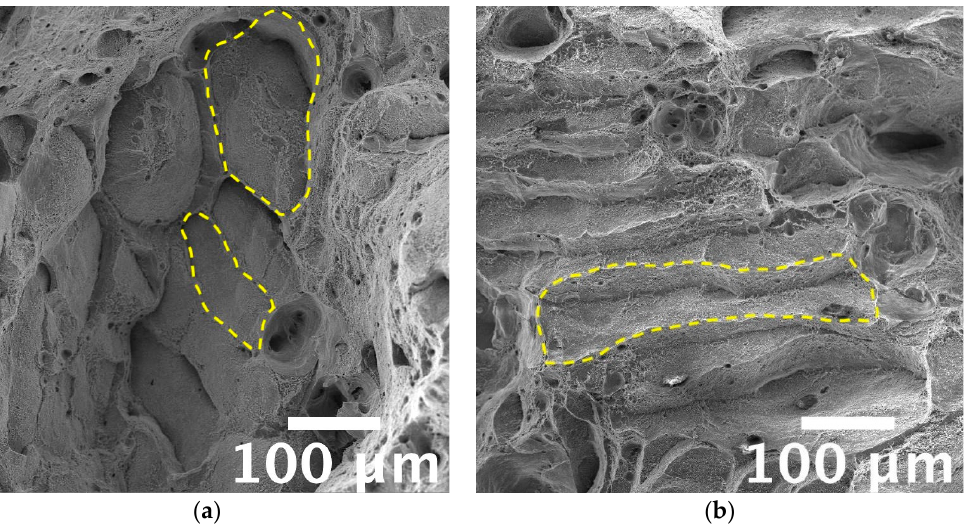
Figure 14. FEG-SEM high magnification fractographic analyses, detail of successive layers de- cohesion on ( a ) AB, ( b ) T5 AlSi7Mg PBF-LB tested at 200 °C. Yellow dashed lines highlight some features related to laser scan tracks.